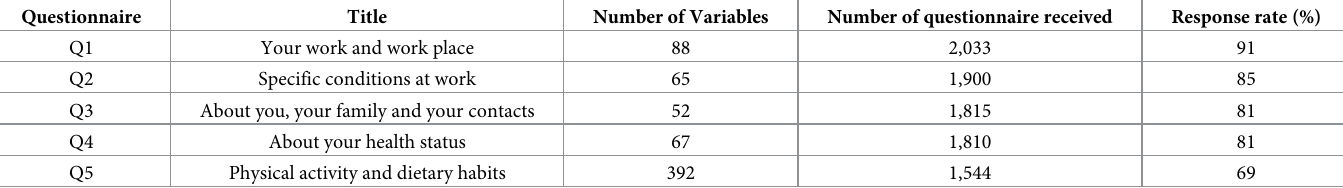
Table 1. Description of the 5 questionnaires sent to the 2,237 participants enrolled in the cohort and their response rate.